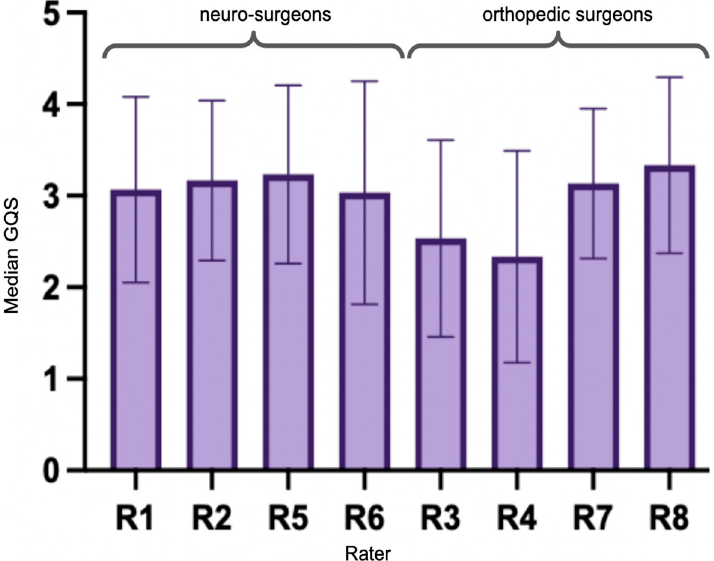
Figure 1. Median GQS for each rater (R1-8). R1, R2, R5, and R6 were neurosurgeons. R3, R4, R7, and R8 were orthopedic surgeons. The latter assigned significantly lower grades to the videos.